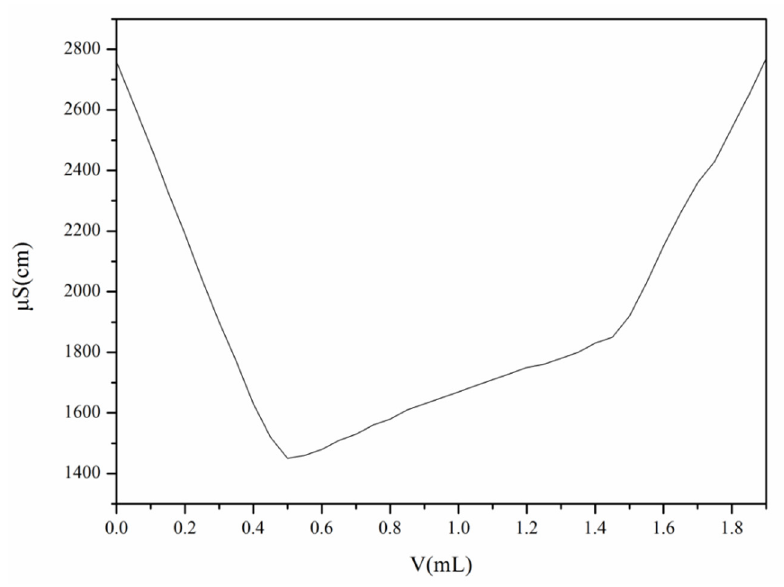
Figure 5. The typical conductometric titration curves of N-2-HACC.